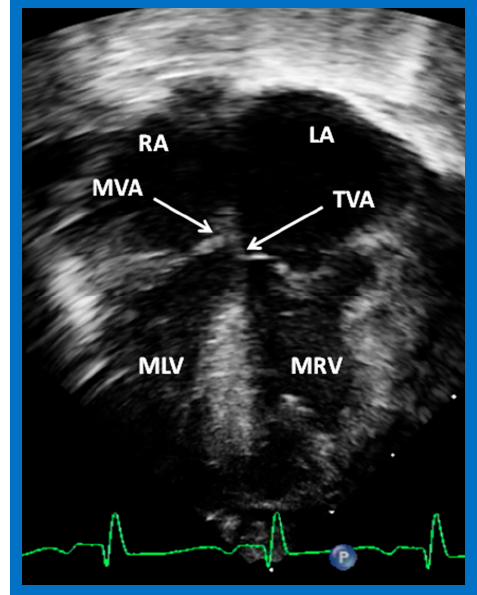
Figure 39. Selected echo image in the apical four-chamber projection of a child with ventricular inversion. Note the superior level of mitral valve attachment (MVA) on the right side relative to the attachment of the tricuspid valve (TVA) on the left side, signifying that the ventricles are inverted. This is a reversal of what is illustrated in Figure 38. Left atrium (LA), morphologic left ventricle (MLV), morphologic right ventricle (MRV), and right atrium (RA) are labeled. Replicated from reference [4].